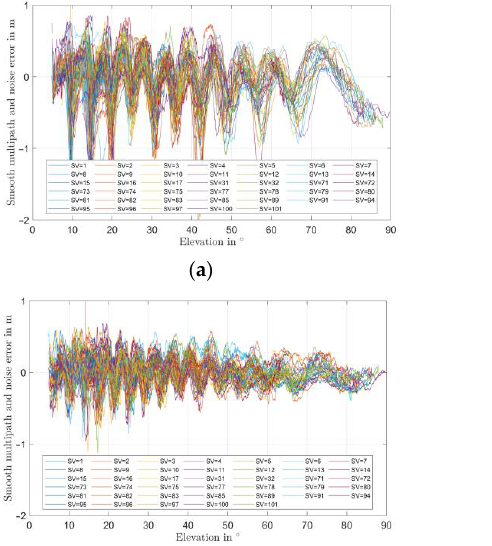
15 of 17 Figure 16. Phi = 0° cut of the measured RHCP and LHCP realized gain patterns of the miniaturized GNSS array (without vertical choke rings) standalone (“SA”) or installed on a hex -rotor UAV (“UAV”) with an installation height of 110 mm. On the other side, the C/N0 values of the array installed on the UAV appear to have less oscillations over the entire satellite path, most notably at the L5/E5a band. This was not related to the antenna pattern itself and hence hints at possible multipath effects con- tributing to oscillations through destructive and constructive interference with line of sight signals. For the array installed on the platform, the effect is lower probably thanks to a good level of shielding provided by the platform itself against multipath from ground bounces. This is also confirmed by the patterns shown in Figure 16, where the cross-po- larized component (LHCP) for directions close to nadir is about 5 dB higher at L5/E5a in standalone configuration than in the UAV case, and hence the antenna suppresses less ground multipath. In order to validate the last observation, 100 s smoothed pseudorange multipath er-